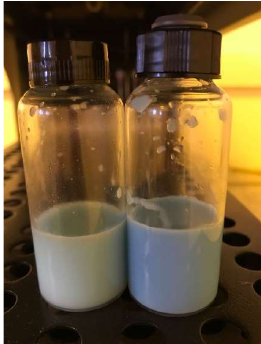
Figure 2. Macroscopic aspect of the emulsion ( left ) and nanoemulsion ( right ) containing ZnPc (picture taken in a yellow light environment to avoid photodegradation of ZnPc).